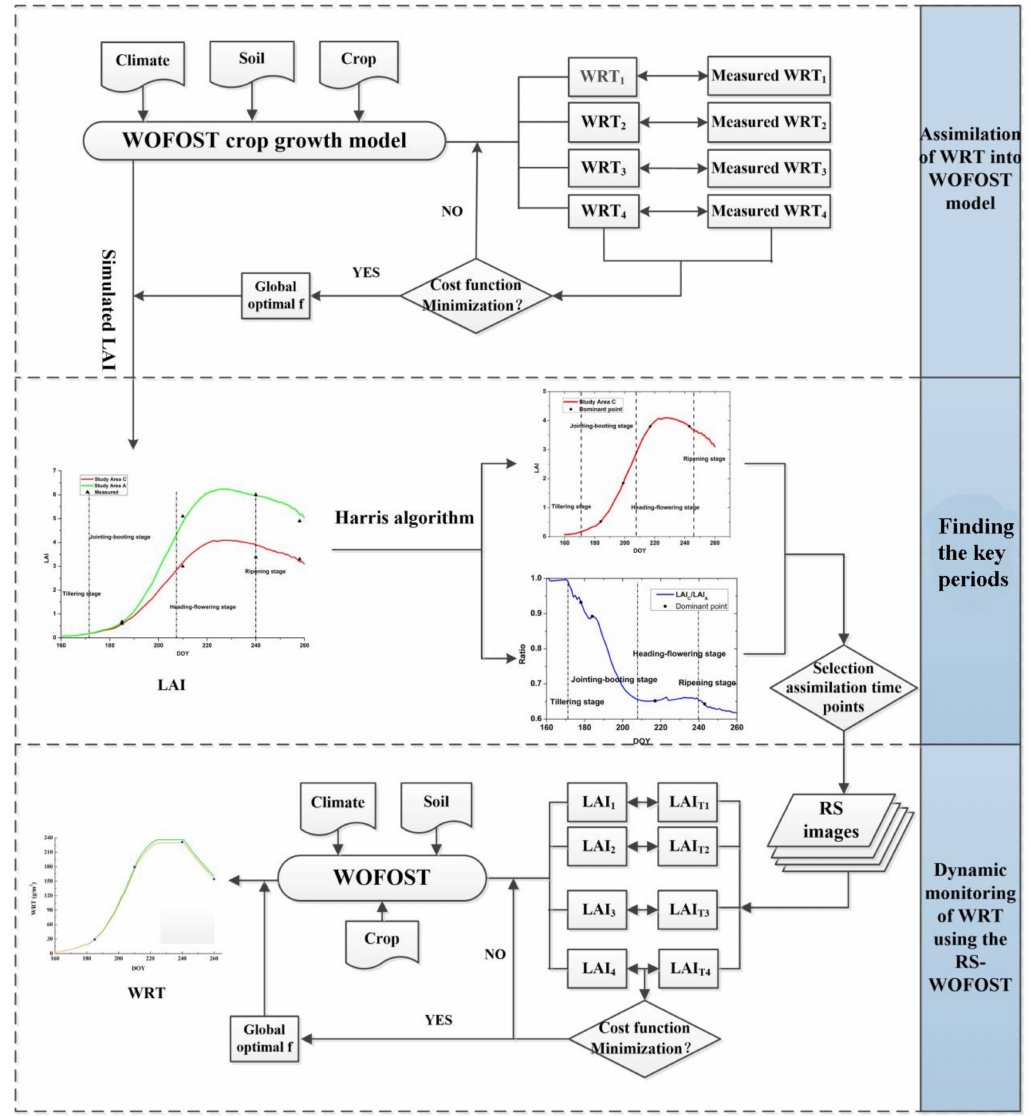
Figure 2. Flow chart of the WRT-WOFOST assimilation framework to find the key periods. (The WRT-WOFOST assimilation framework means assimilating the WOFOST model with